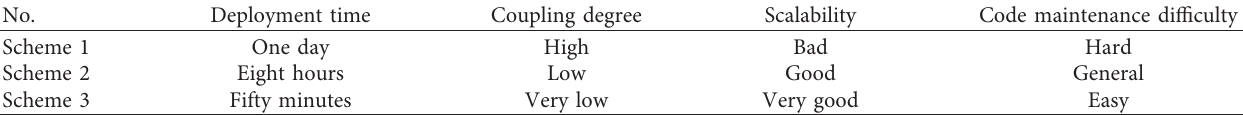
Table 1: Comparison of three schemes in detail.